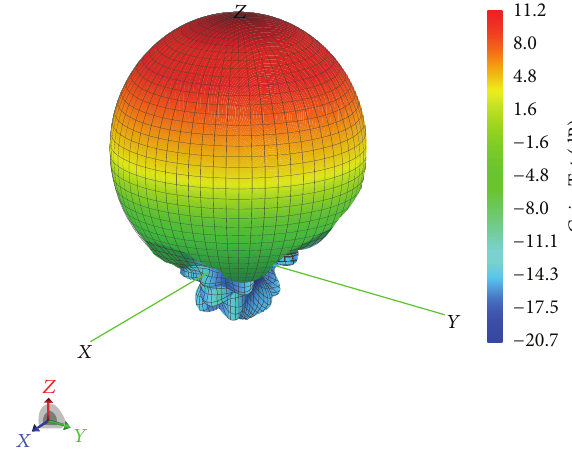
Figure 7: 3-D feed antenna pattern.